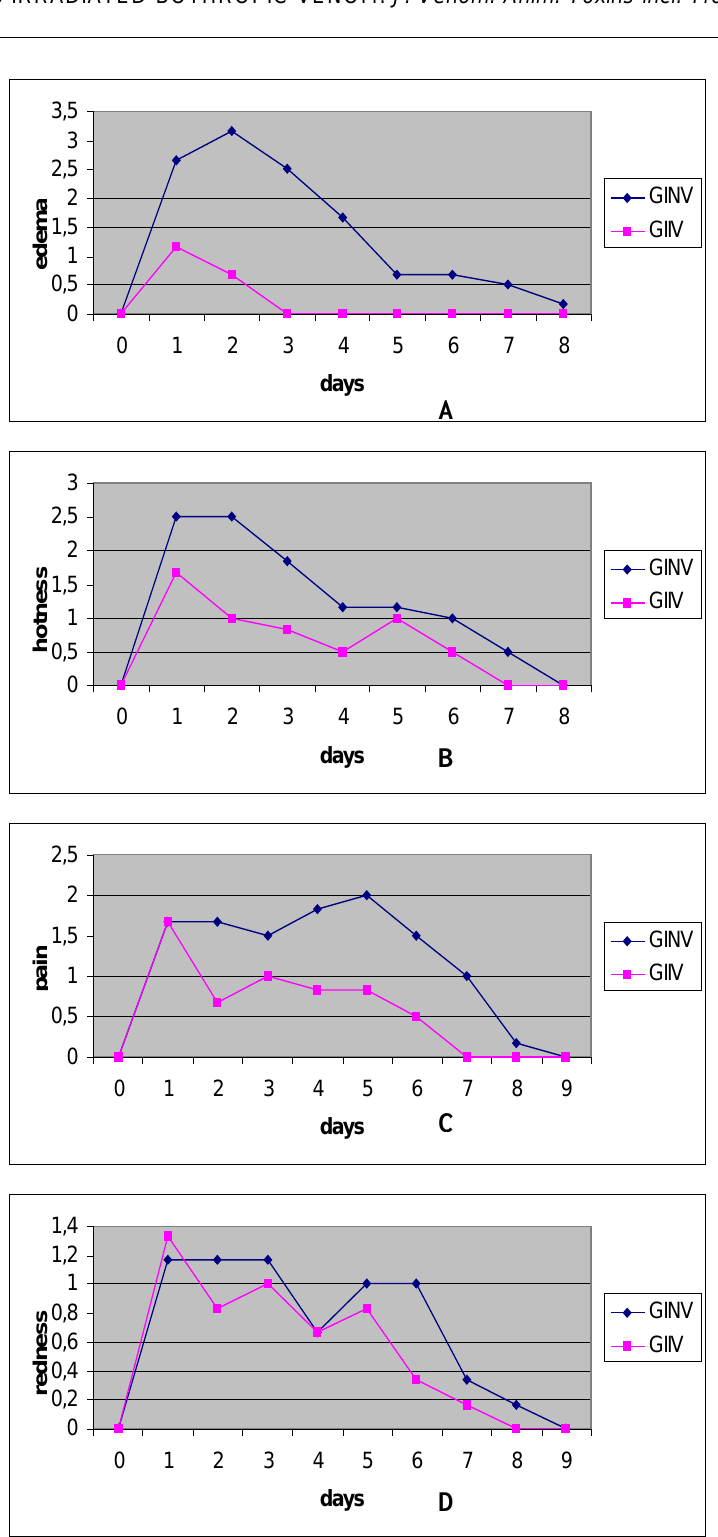
Figure 1. Clinical signs (A: local edema, B: hotness, C: pain, D: redness) in animals of the group inoculated with natural venom (GINV) and the group inoculated with irradiated venom (GIIV) before and after venom